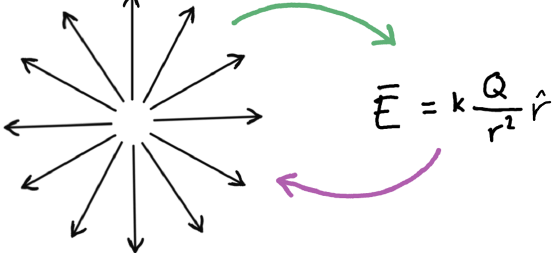
FIG. 4. A conversion between the graphical register and the algebraic register. The difficulty of performing a conversion has been shown to depend on the direction of the conversion. Here the conversion is between a field line representation of an electric field and the formulaic representation of the field. Students must recognize that both semiotic representations aim to represent the same mathematical